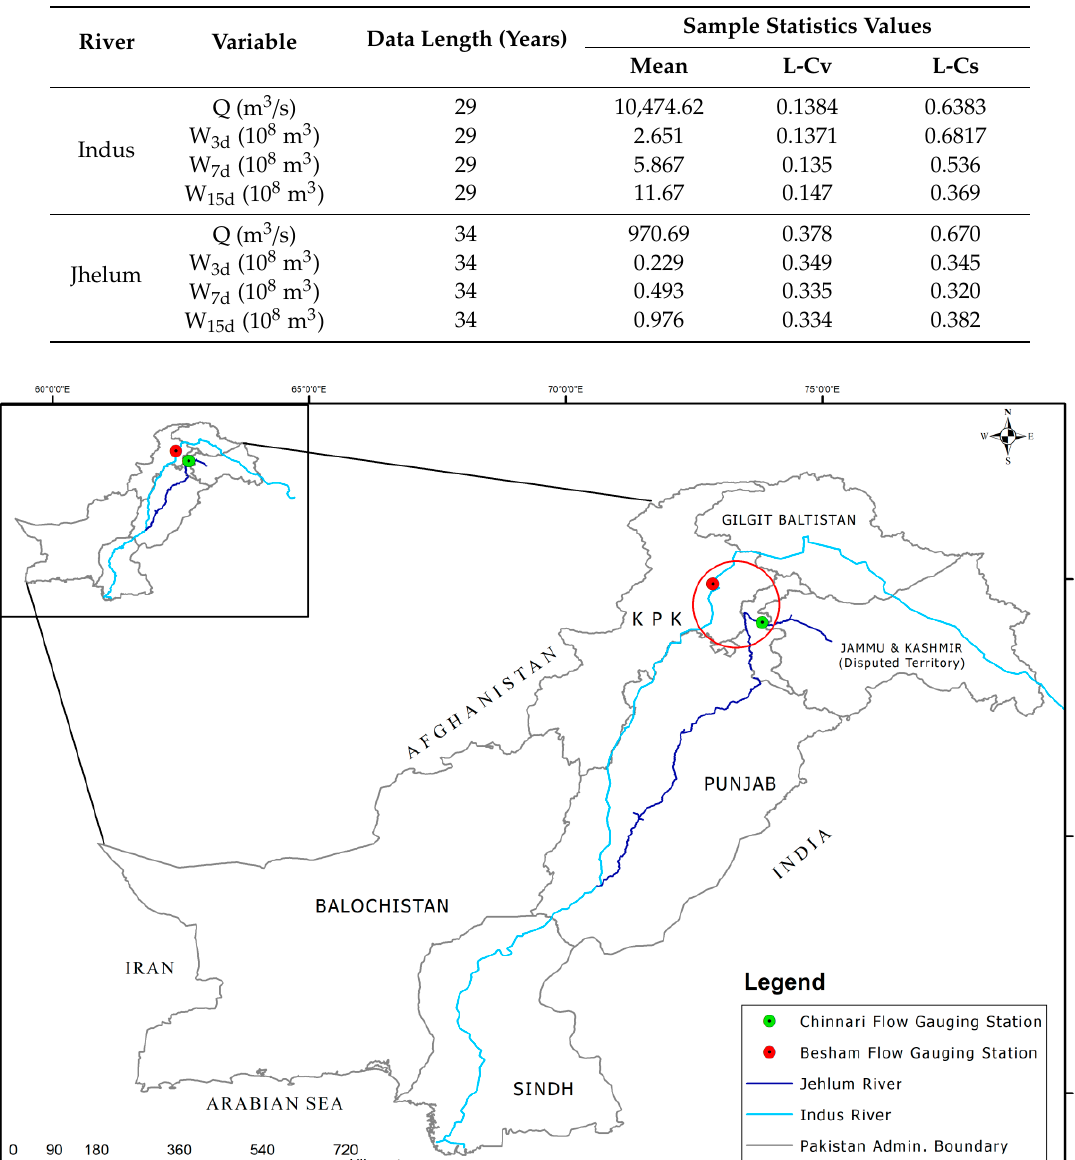
Table 1. Sample data statistics values of variables at Indus and Jhelum rivers.